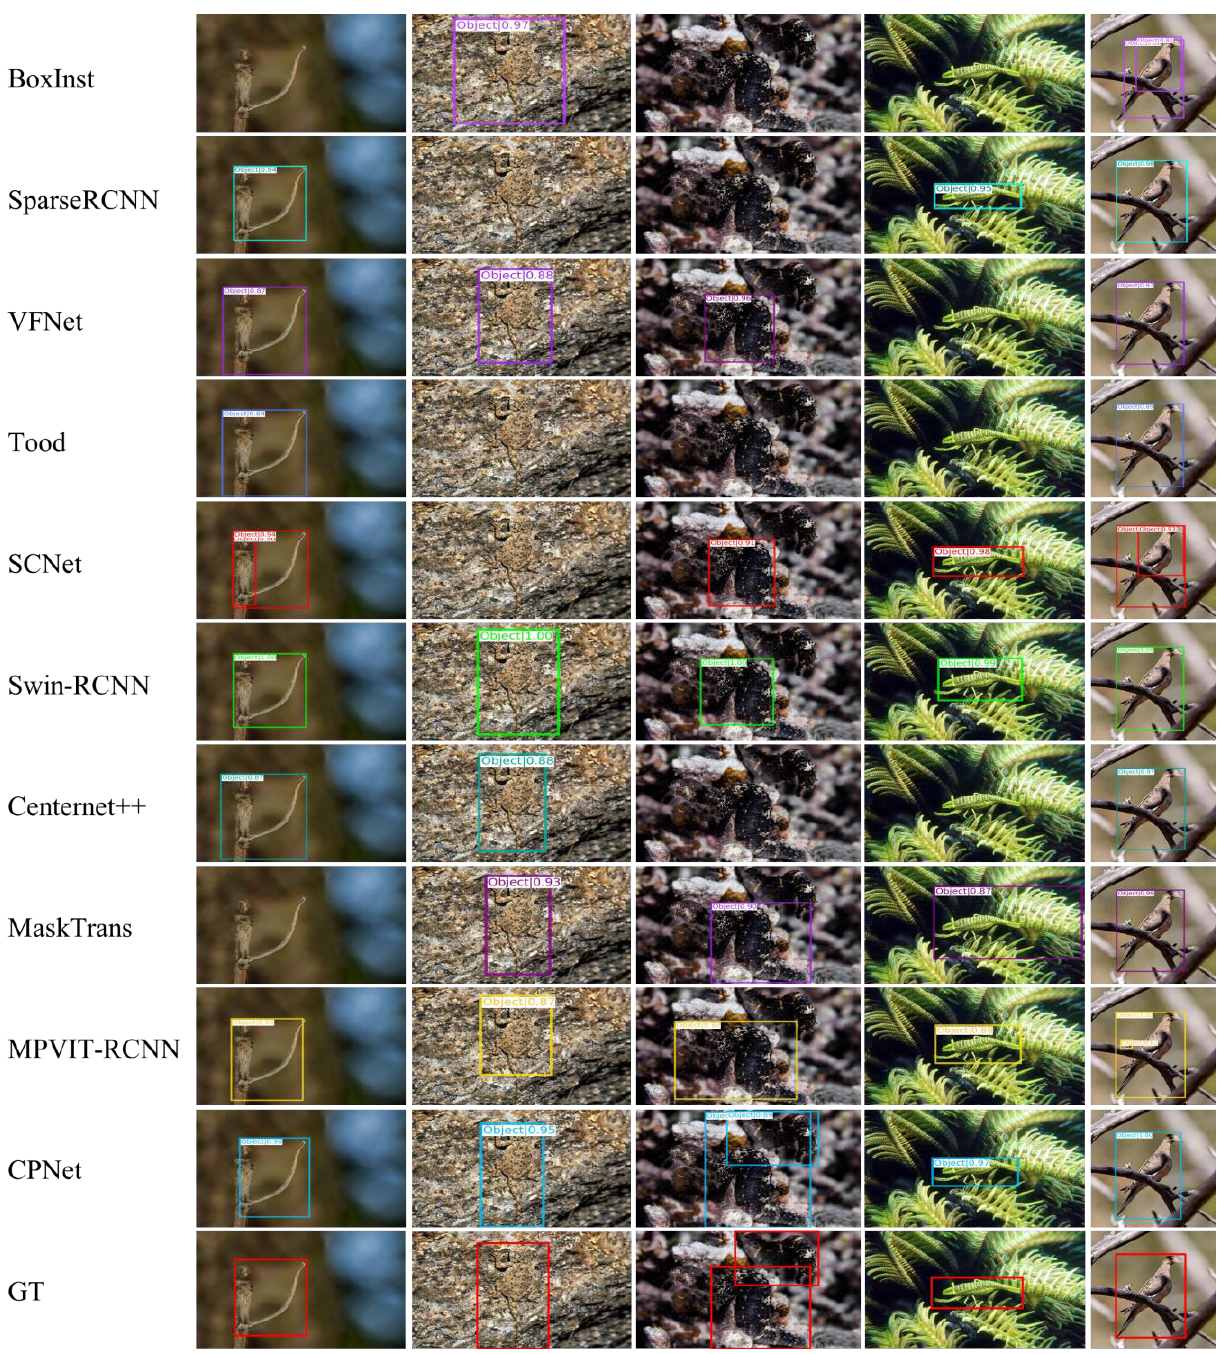
Figure 10. The visualization results obtained by all algorithms in the cross-sectional comparison experiments. (GT represents ground truth). experiments. (GT represents ground